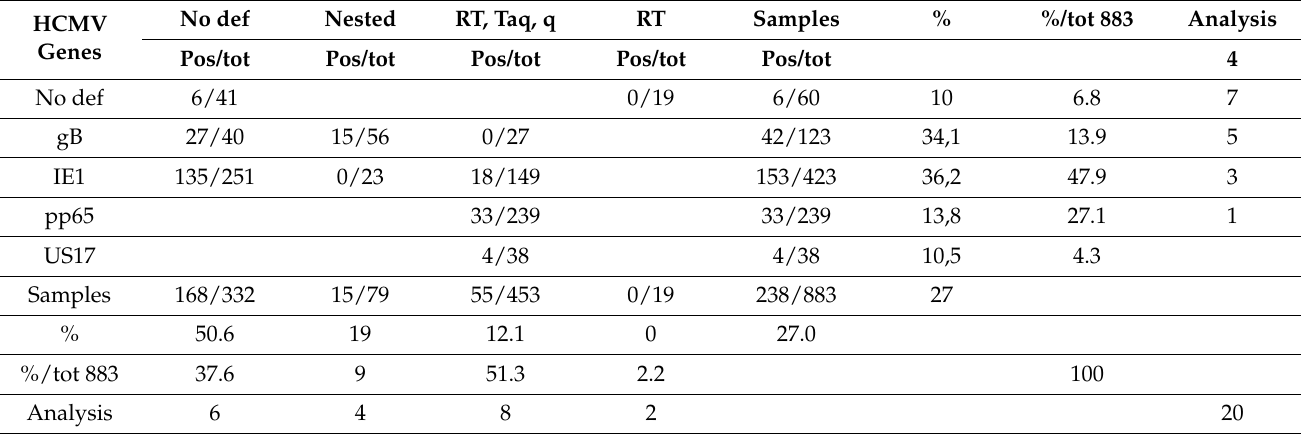
Table 8. Summarized results from published studies for the detection of the HCMV genome in blood samples obtained from GBM patients using PCR methods.